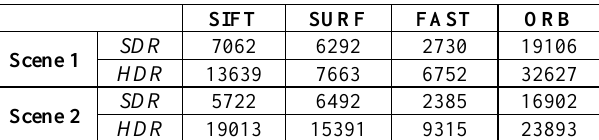
Table 1: Average feature points detected on SDR and HDR images for both scenes.